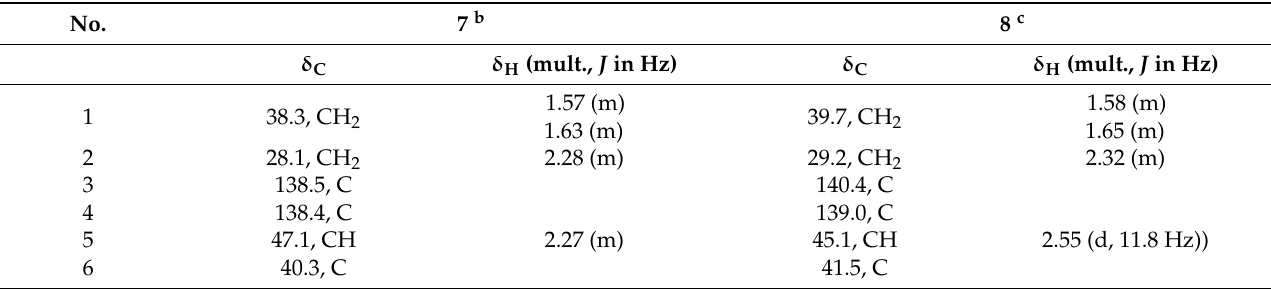
Table 3. 1D and 2D NMR spectroscopic data of compounds 7 – 8